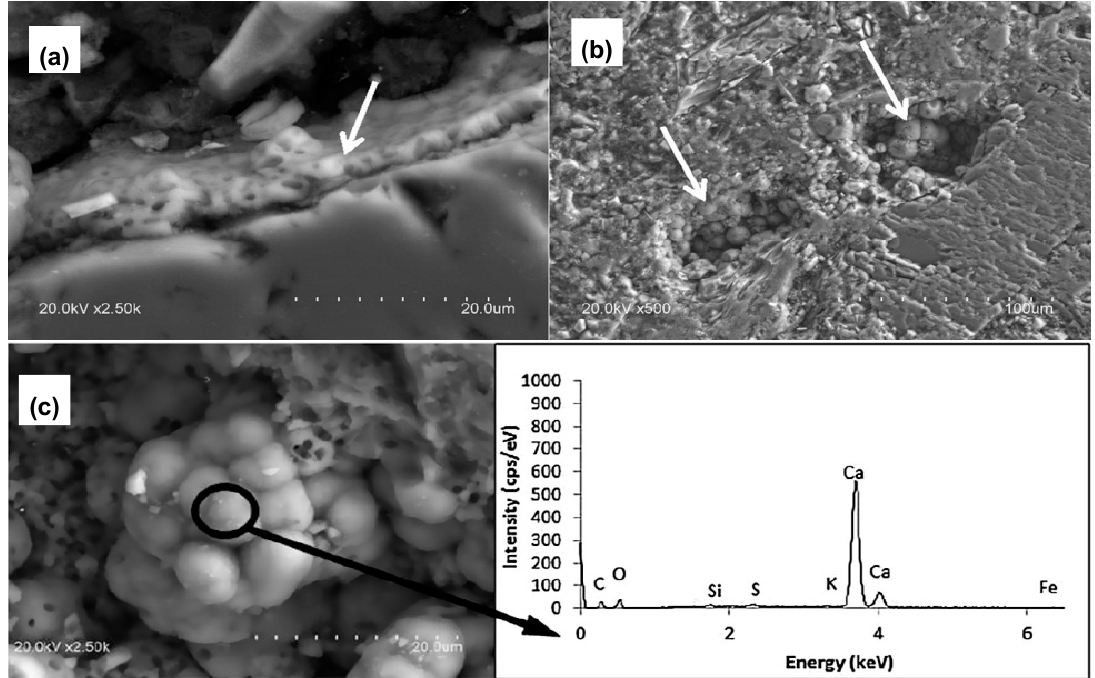
Figure 8. SEM images of ( a ) CaCO 3 precipitated over recycled aggregates surface, ( b ) CaCO 3 precipitated inside a pore of recycled aggregates (RA) sample, ( c ) CaCO 3 globular precipitate with Energy-dispersive X-ray spectroscopy (EDX) spectrum showing the composition of the precipitate. Adapted with permission from [78] 2017, Elsevier.